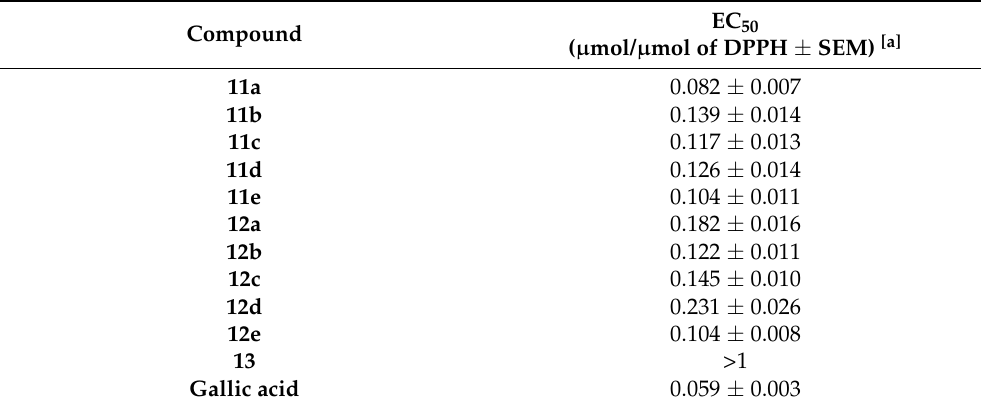
Table 3. Free radical scavenging activity against DPPH for the studied set of compounds ( 11a–e , 12a–e , and 13 ) and gallic